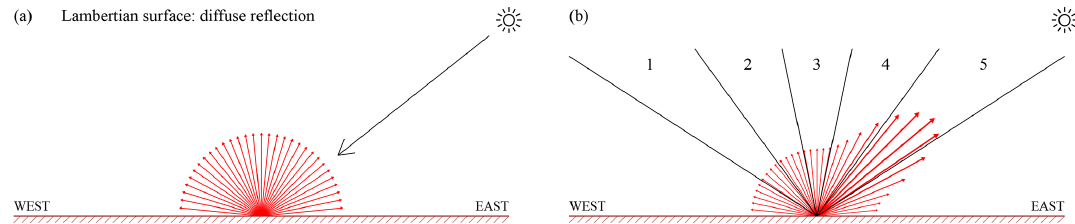
Figure 1. (a) Illustration of the principle of Lambertian (isotropic) surface reflection. (b) Surface reflection distribution with a retroreflection lobe, representative of land surfaces covered by vegetation. In the DLER retrieval code, the orbit swath is divided into five viewing angle ranges, and for each segment the surface LER is determined in the usual way.